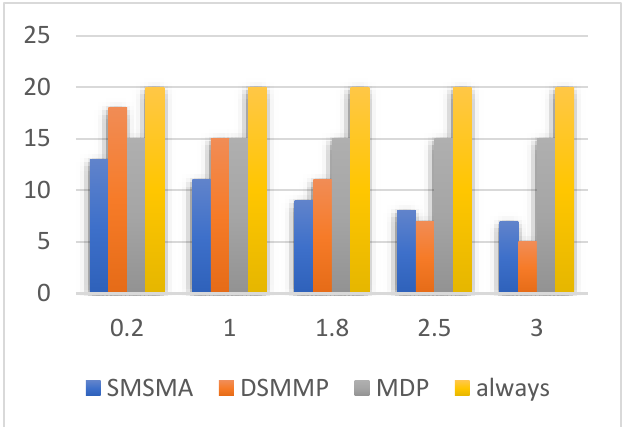
Figure 10. Effect of movement gain on the number of migrations.